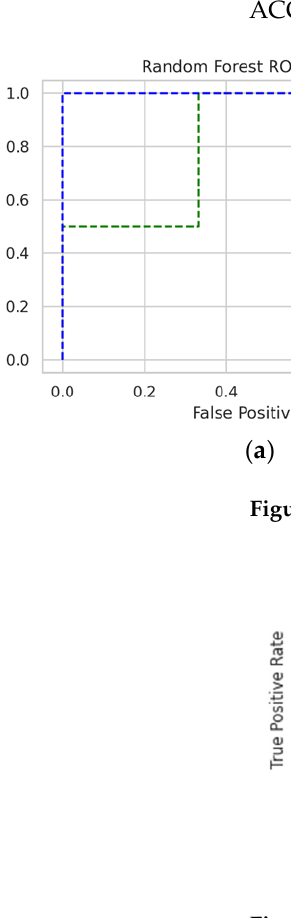
( b ) Figure 11. Accuracies of ML models on textual and numerical datasets ( a ) using ACO and ( b ) with ‐ out using ACO. AUC ‐ ROC statistics aid in determining a model’s capacity to discriminate across clas ‐ ses [50]. Hence, we decided to offer the experimental results in the most generally used evaluation measure, clarifying why we chose such a pipeline. The ROC ‐ AUC curve was plotted for the best models integrated with ACO on textual and numerical datasets. The ROC curves were plotted for Random Forest classifier on ACO, using TF ‐ IDF and BoW as